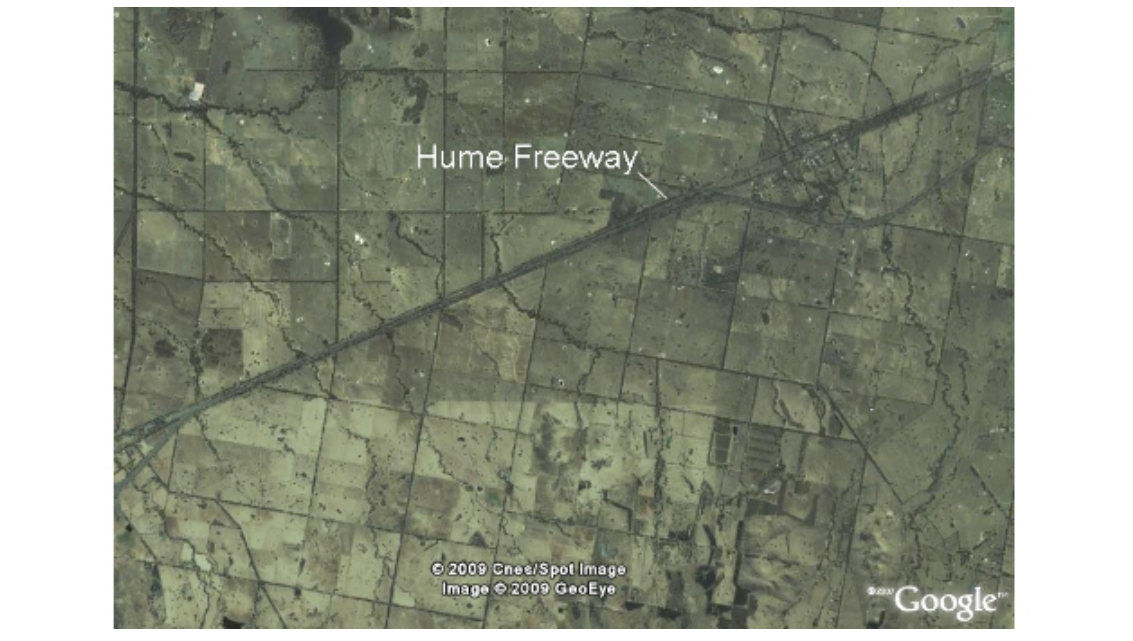
Fig. 2. Aerial photograph of a section of the study area along to the Hume Freeway, northeastern Victoria, Australia. The photograph shows how remnant vegetation occurs mainly along roads (linear dark lines) and waterways. (Source: GoogleTM,